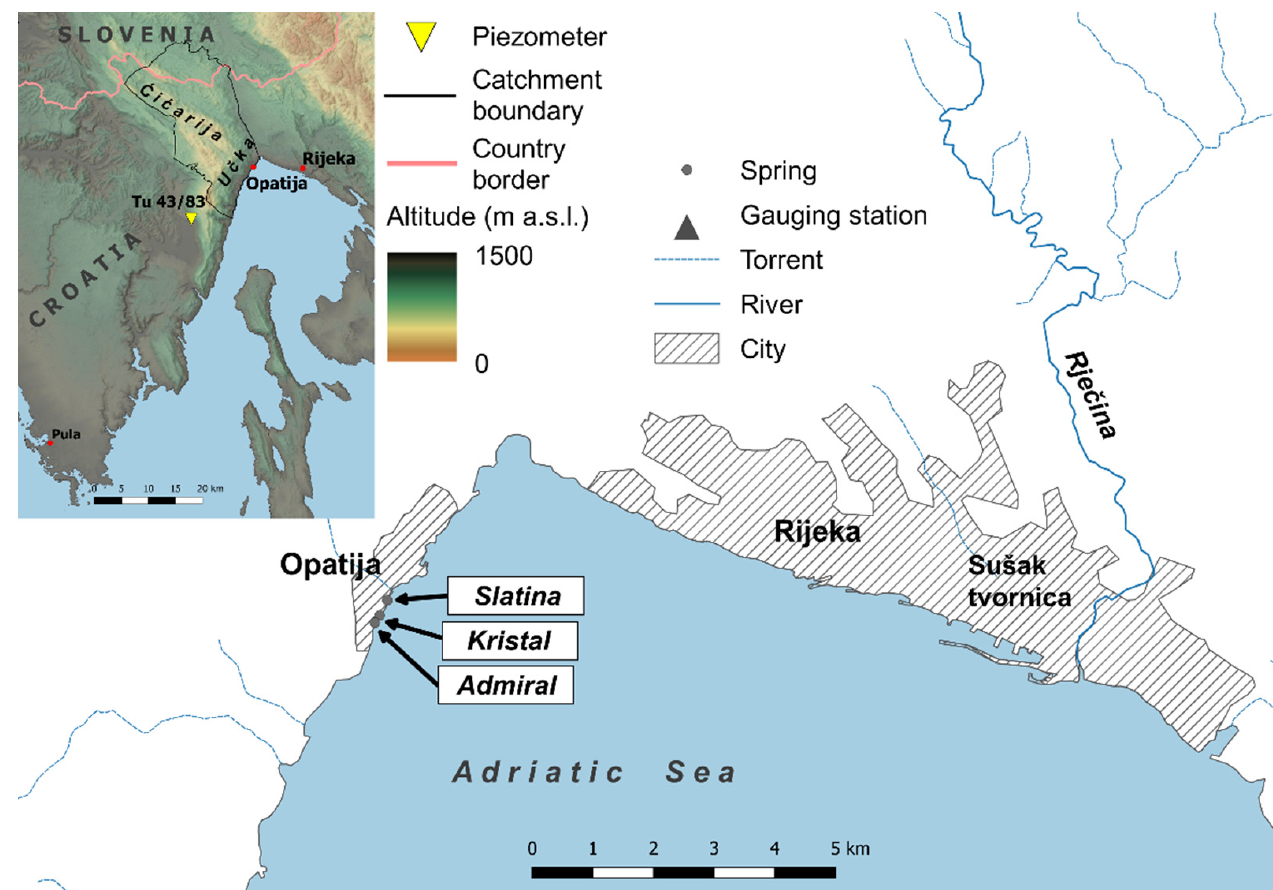
Figure 1. Location of the Opatija springs: Slatina, Kristal, and F igure 1. Location of the Opatija springs: Slatina, Kristal, and Admiral. Kristal and nearby coastal springs drain the catchment area of 365.80 km 2 (Figure 1).